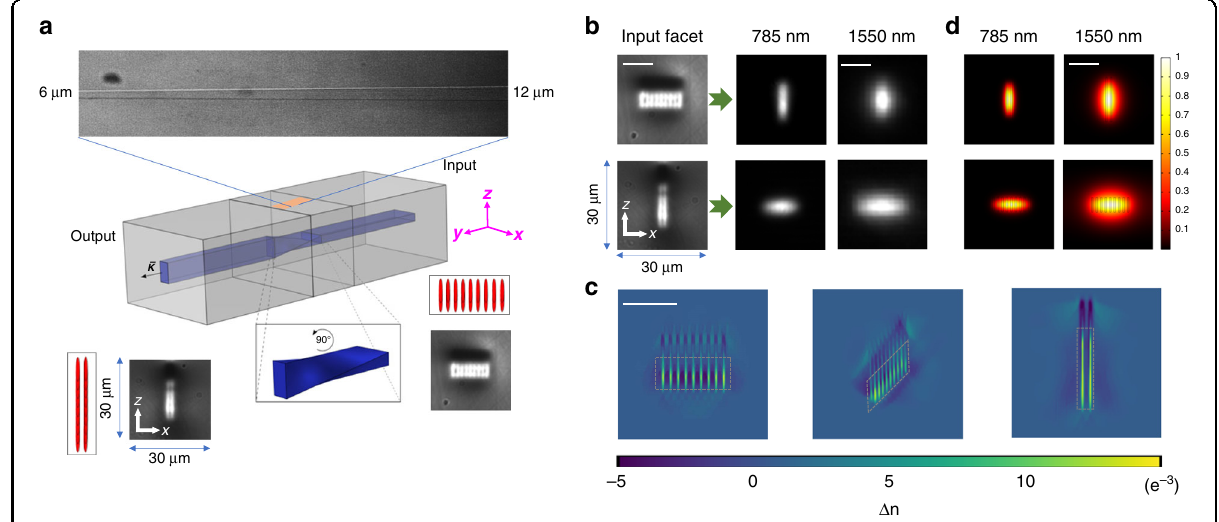
Δ Fig. 2 Characterization of twisted shape SPIM-WGs. All images (LED, laser, simulation) have the same frame size of 30 × 30 µm. Scale bars are 10 µm. a Composition of a twisted waveguide. The lengths of z- aligned rectangular, twisted, x- aligned rectangular regions were 9.3 mm, 1.4 mm, 9.3 mm, respectively, for the studied waveguide. LED microscopic image top view of the fabricated sample is included, where a transition from 6 µm width to 12 µm width is clearly seen from the top 3D to 2D projection. Multi-scans of the laser spot at waveguide facets are shown as schematics. Coordinates: x / z transversal axis, y longitudinal axis. b Rectangular beam rotation can be achieved by a twisted waveguide, with 785 nm laser and 1550 nm laser tested, respectively. Top: light guided from x- aligned rectangular input facet was converted to z- aligned rectangular modes. Bottom: light guided from z- aligned rectangular input facet was converted to x- aligned rectangular modes. c Measured refractive index pro fi les by a 3D tomographic microscope. Dashed boxes highlight positive refractive index regions which was able to guide laser light. Refractive index contrast was measured as high as 0.017. d COMSOL simulations of mode intensity distribution for 785 nm laser and 1550 nm laser. The simulations were conducted based on measured refractive index data in the positive region from a tomographic microscope (highlighted by dashed